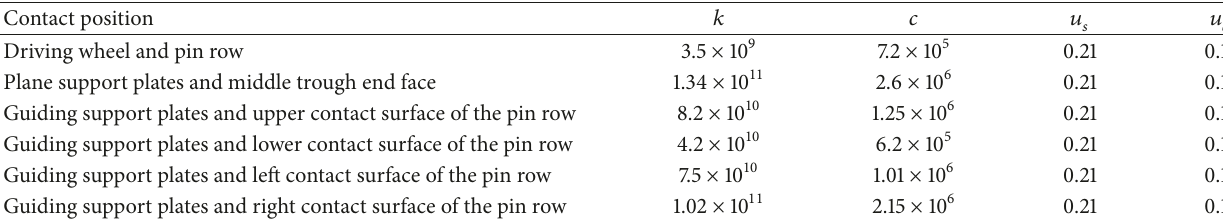
Table 2: Contact surface parameters.